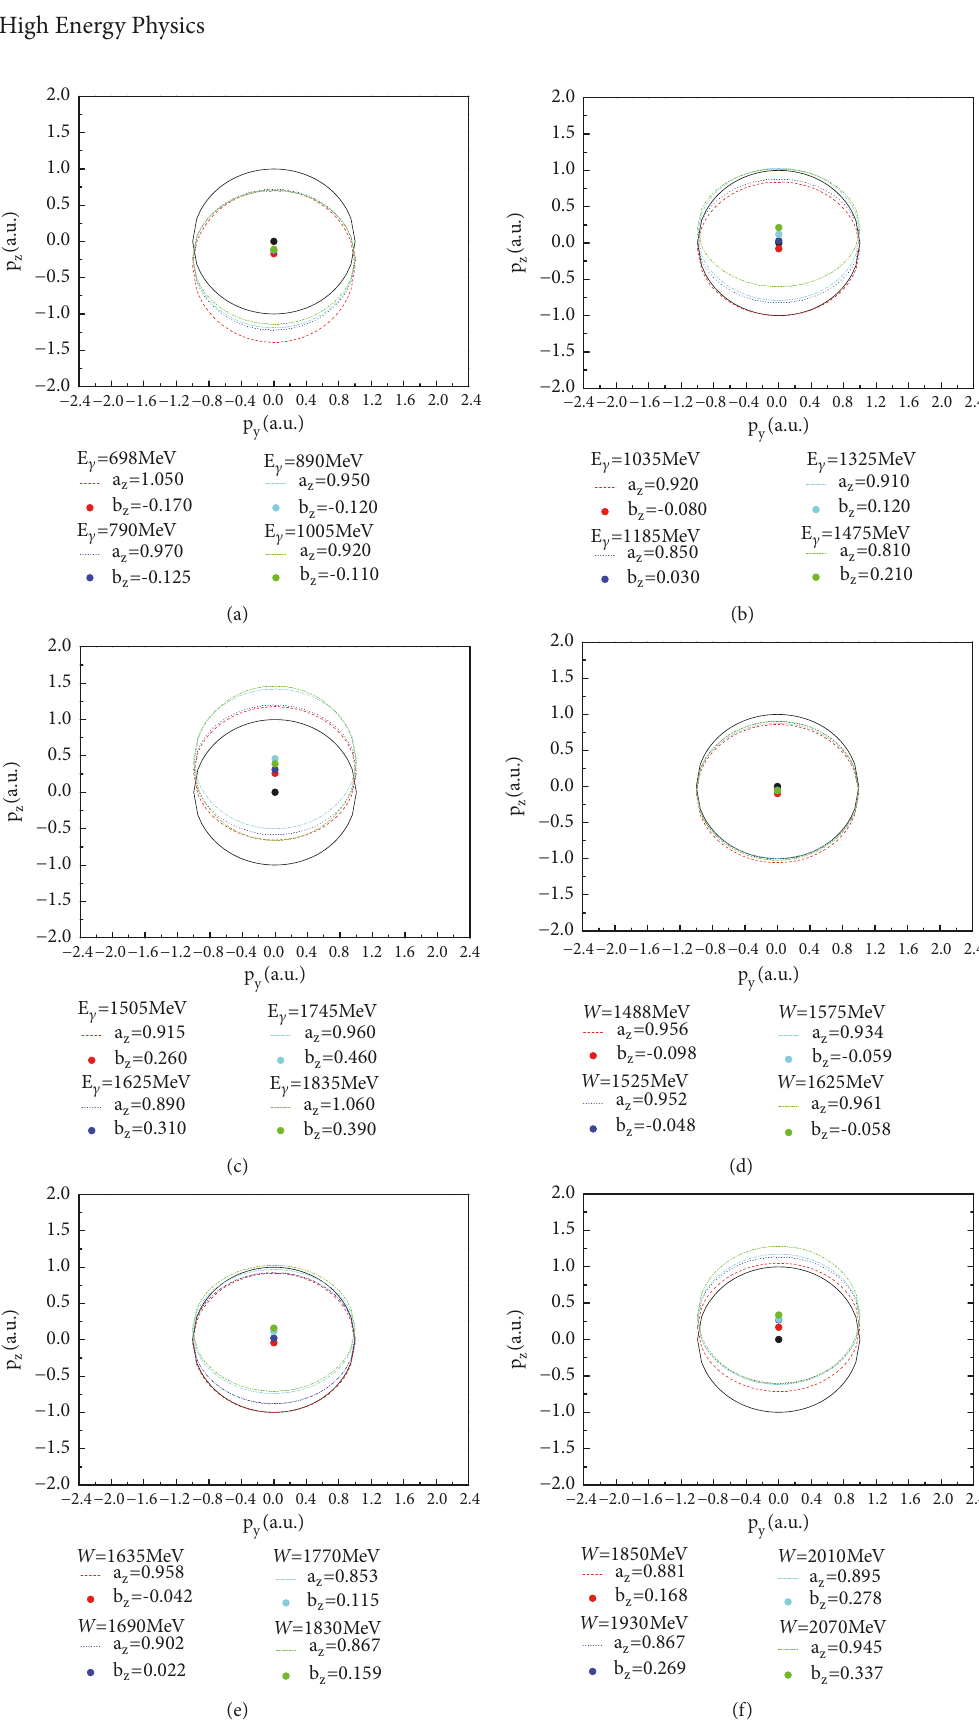
Figure 7: The deformable and translational source in the reaction plane for different bins of incident photon energy E 𝛾 or final state energy 𝑊